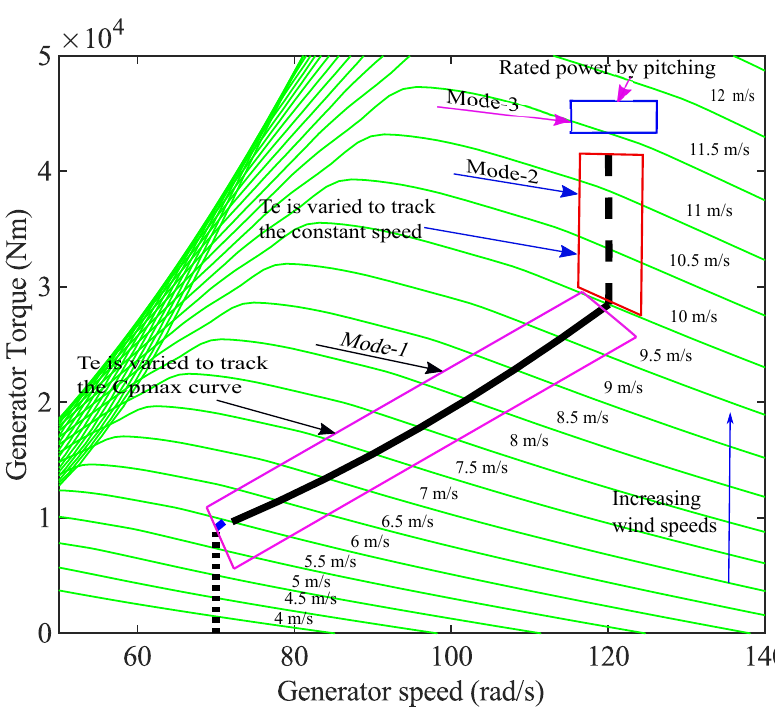
Figure 7. Control objective in each operating mode on torque/speed plane.